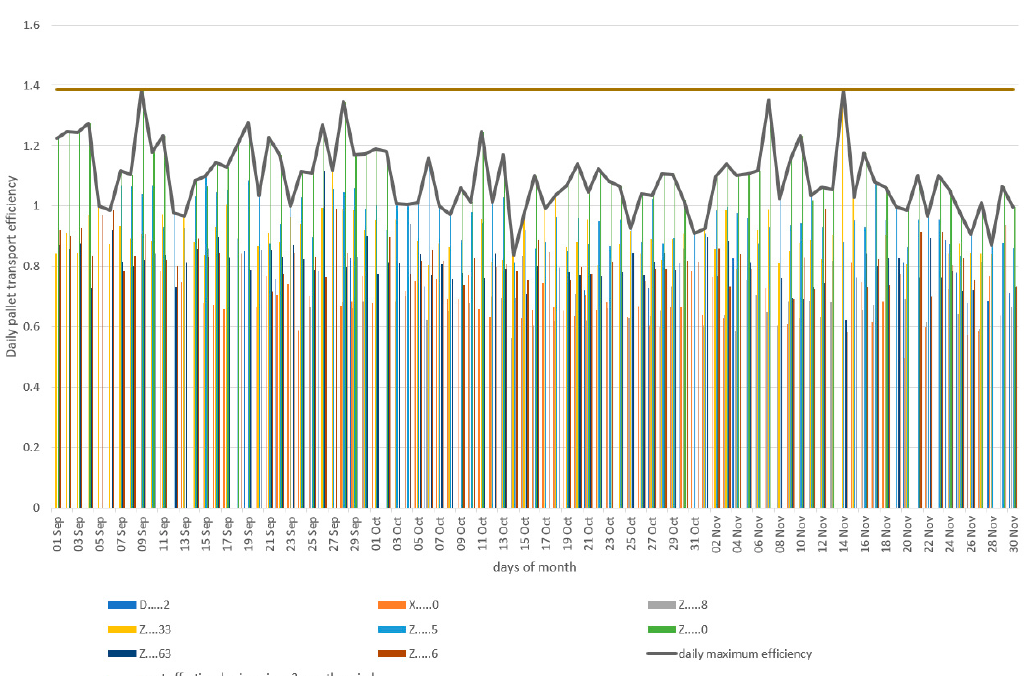
Figure 10. Daily efficiency—the weighted ratio of the number of transported pallets to the amount of fuel consumed over a distance of 100 km, where the reference is the most effective day in a given 3-month period.